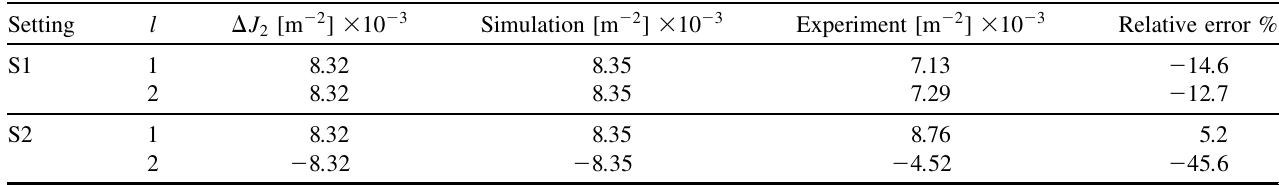
TABLE V. Additional strength applied in the skew sextupoles and retrieved value via NTRM.